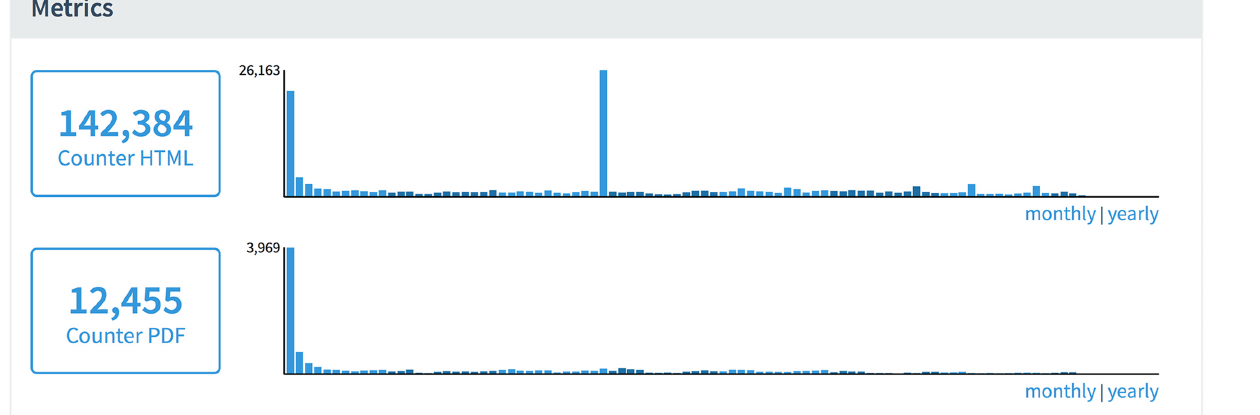
Fig 4. PLOS Medicine article with irregular page view